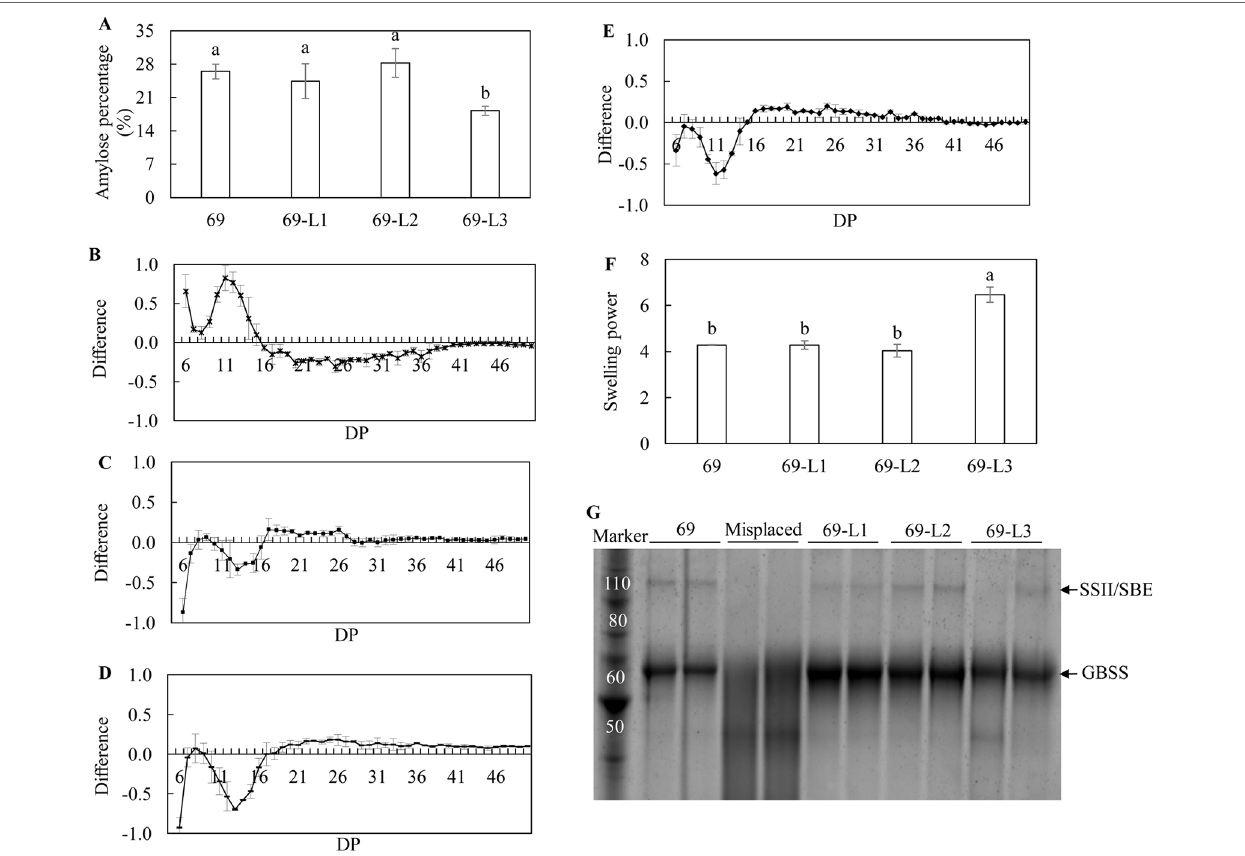
FigURE 7 | Analysis of the starch properties in the mature potato tubers. (A) Amylose ratio; (B) Difference of chain length distribution (CLD) between debranched starch of 69 and WT; (c) Difference of CLD between debranched starch of 69-L1 and 69; (D) Difference of CLD between debranched starch of 69-L2 and 69; (E) Difference of CLD between debranched starch of 69-L3 and 69; The CLD was reflected as DP. Each mark above the horizontal axis corresponds to the difference of a chain length in mole percentage. The error bars are standard errors. The difference value was obtained by subtracting the CLD of 69 from the three super- transformed lines, respectively. (F) Swelling power of potato flour; (g) SDS-PAGE of potato starch GBPs. The two obscure tracks between 69-L3 and 69-L2 are misplaced samples which are irrelevant with other samples. The data represent the mean values ± SD of three biological replicates. Letters (a, b, c) above the bars are based on LSD, bars marked with different letters are statistically significantly different at P <